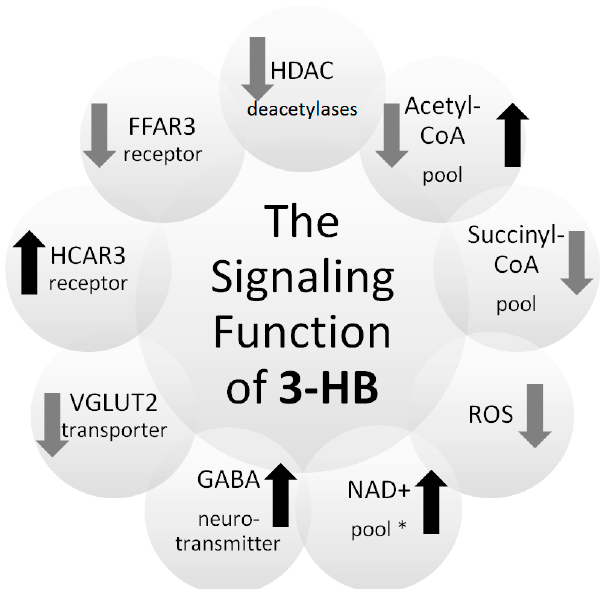
Figure 2. Regulatory functions of 3-hydroxybutyrate. 3-HB–3-hydroxybutyrate, CoA-coenzyme A; FFAR3–free fatty acid receptor 3; GABA– γ -amino butyric acid, HDAC–histone deacetylases, HCAR2–hydroxycarboxylic acid receptor 2; NAD–nicotinamide adenine dinucleotide; VGLUT– vesicular glutamate transporter. black arrow–activation, grey arrow–inhibition; * compared with glucose metabolism.